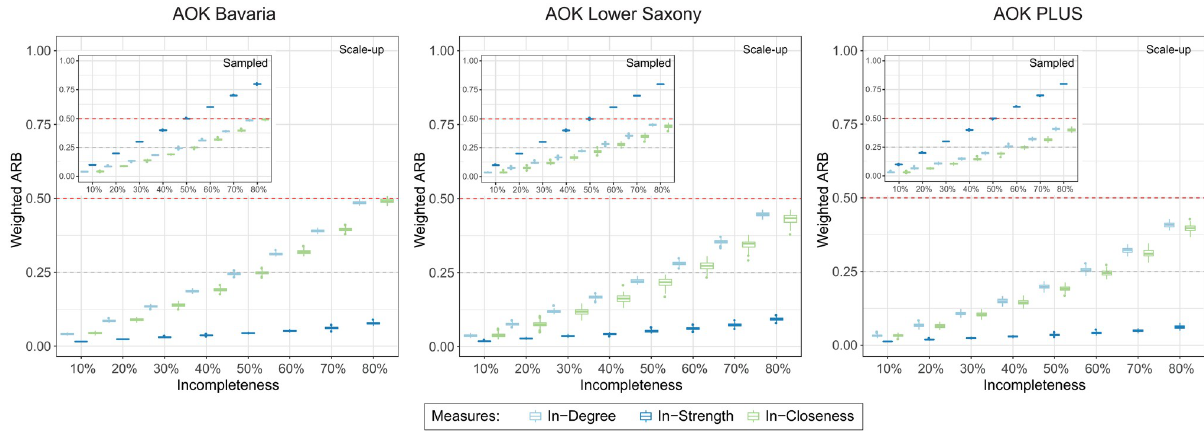
Fig 2. Impact of sampling and scale-up on direct hospital network measures (visualized in boxplots). The weighted absolute value of relative biases (ARBs) across different network measures on sampled (inset) and scale-up (main plot) datasets for various incompleteness levels. Incompleteness was defined as the percentage of removed patients from the original datasets.